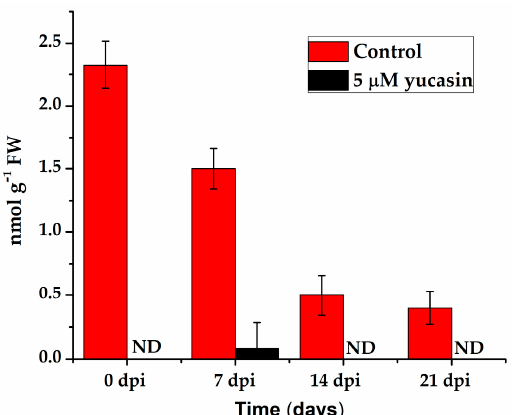
Figure 9. Quantification of the IAA endogenous content in leaf explants of C. canephora treated with 5 µM yucasin. Samples were collected at 0, 7, 14, and 21 days after SE induction. The bars over the columns represent the mean value ± standard error of three independent experiments. ND: not detected.